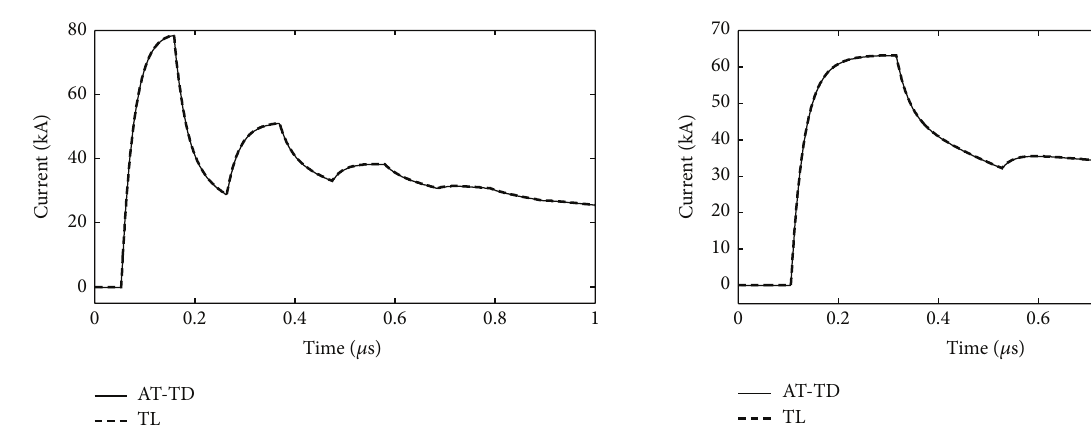
Figure 10: Transient current at the centre of the electrode: 𝐿 = 20 m, 𝜎 = 1 mS/m, and 0.1/1 𝜇 s